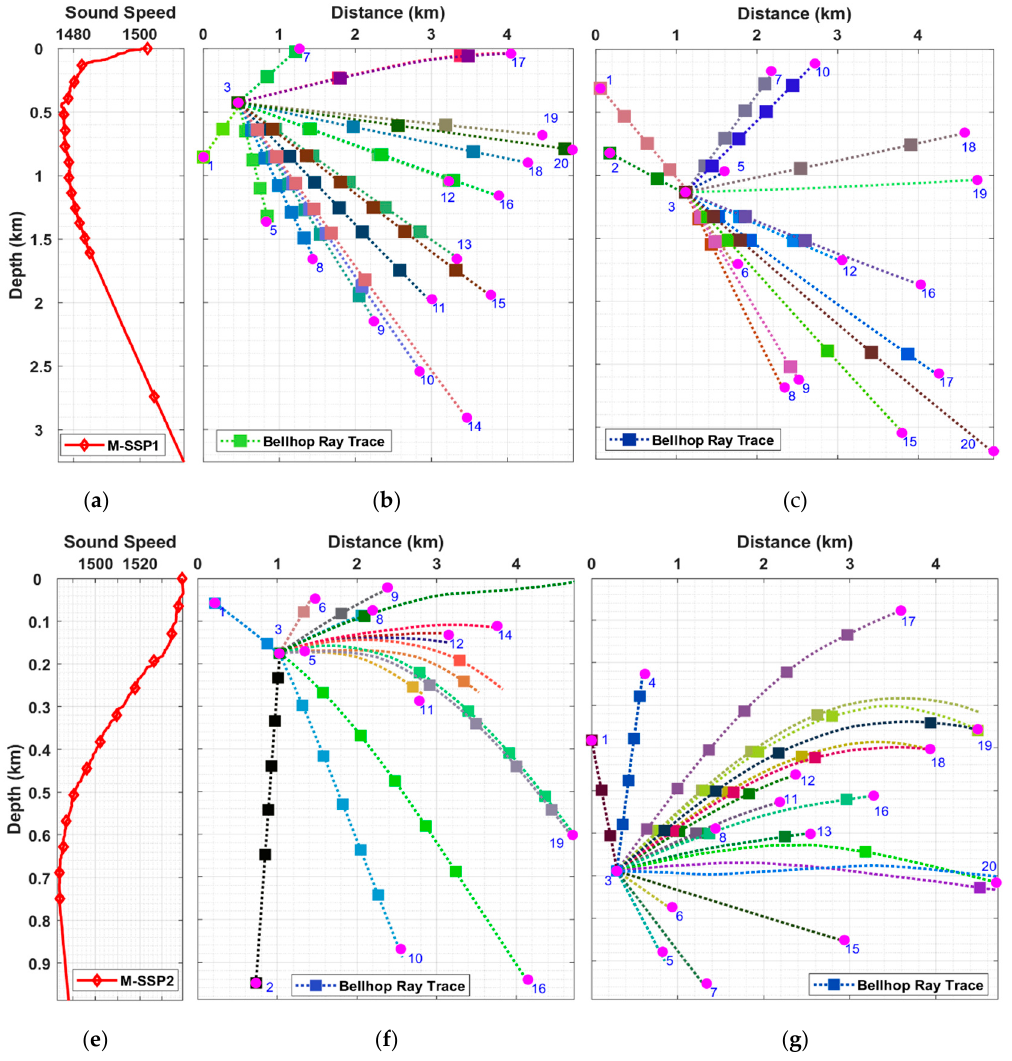
Figure 12. Propagation path of selected acoustic signals shown in different deployment configurations. Part ( a ) and ( d ) show the SSP for the figures in the same row while parts ( b ), ( c ), ( d ) and ( e ) show the node distribution for each deployment configuration and the corresponding refracted rays only among pairs.